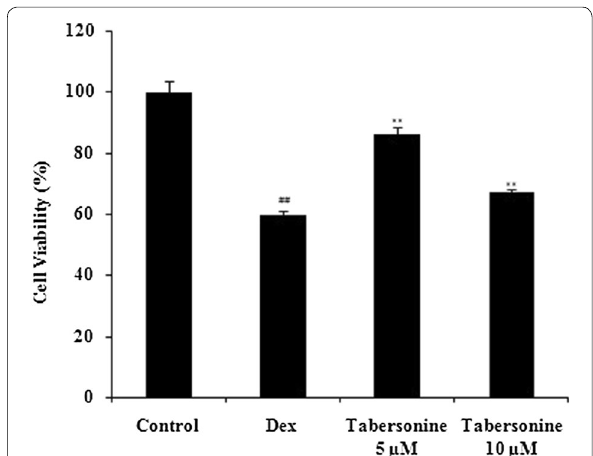
Fig. 1 Effect of tabersonine on osteoblast viability after dexamethasone treatment, evaluated using the CCK-8